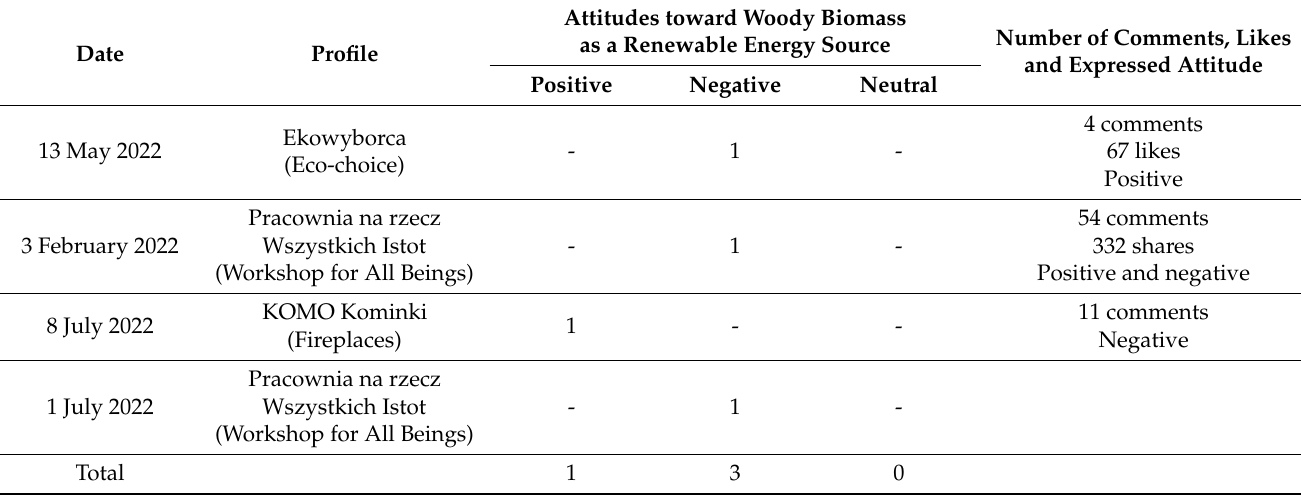
Table 4. Social media 2: Facebook (D)